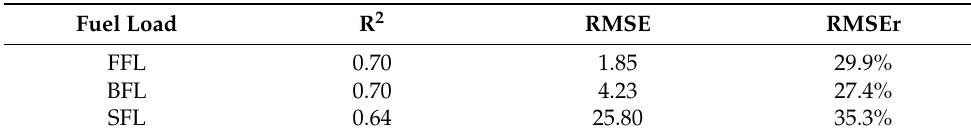
Table 3. Retrieval results of FL AGL (FFL, BFL and SFL) by HV polarization backscatter alone using